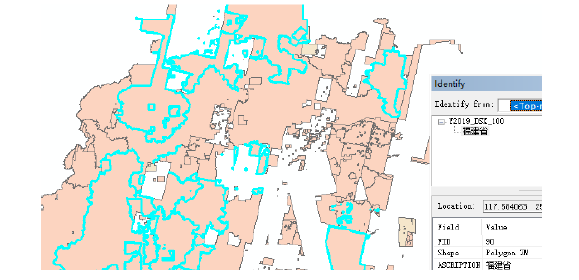
Figure5. Spatial errors detected by system